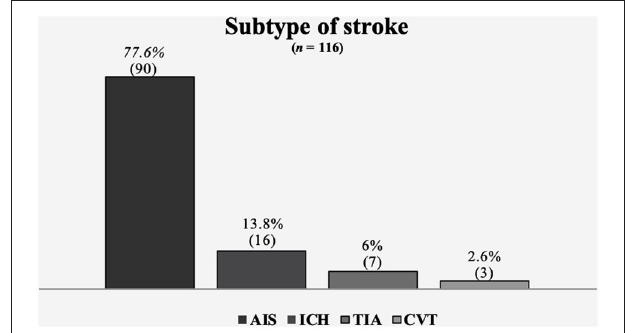
FIGURE 1 | Subtype of stroke. AIS, acute ischemic stroke; ICH, intracerebral hemorrhage; TIA, transient ischemic attack; CVT, cerebral venous thrombosis.